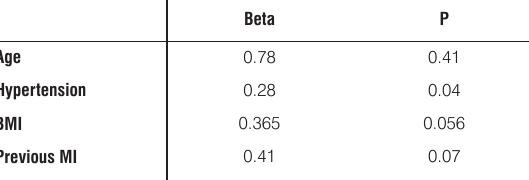
Table 3. Results of multivariate